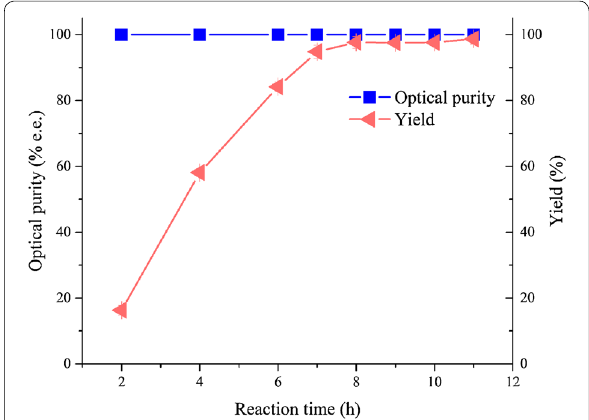
Fig. 7 Reaction process of CR2-L-GDH catalyzing asymmetric syn- thesis of ( S )-DHTP. The reaction was carried out in 10 mL TEA buffer (0.1 mol L − 1 , pH 8.4) comprising 20 g L − 1 DKTP with addition of 40 g L − 1 glucose and 0.1 mmol L − 1 NADP + at 40 °C and 200 rpm. All